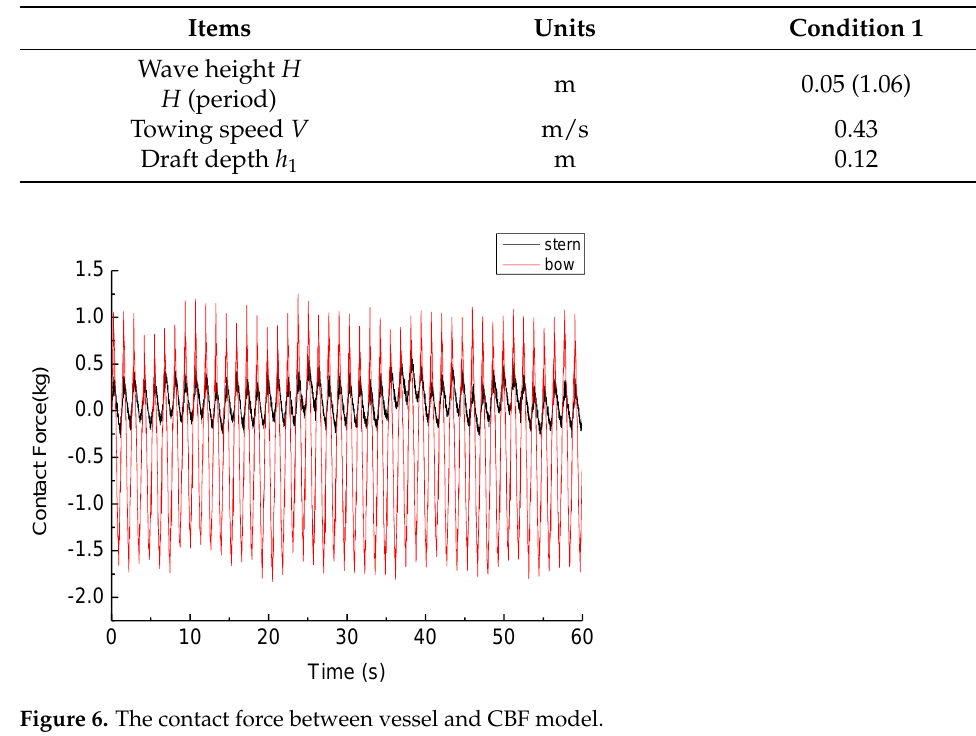
Figure 7. The curve of contact force vs. time considering wave height effect.